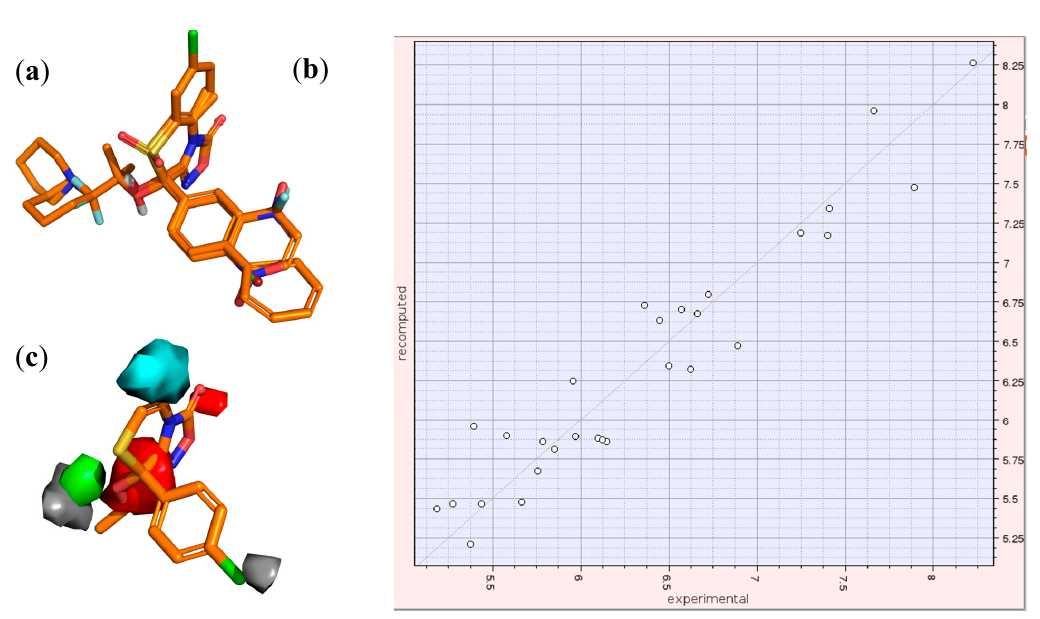
Figure 4. The three steps of 3D-QSAR model: ( a ) alignment of the structures; ( b ) graphical analysis of the IVPLS model; ( c ) inspection of the MIF/pseudofields together with the 3D-structure of the active molecules in order to understand the key regions for the activity. Pseudofields colours of section (c): hydrophobic = green; halogen = grey; aromatic = cyan; H-bond acceptor =